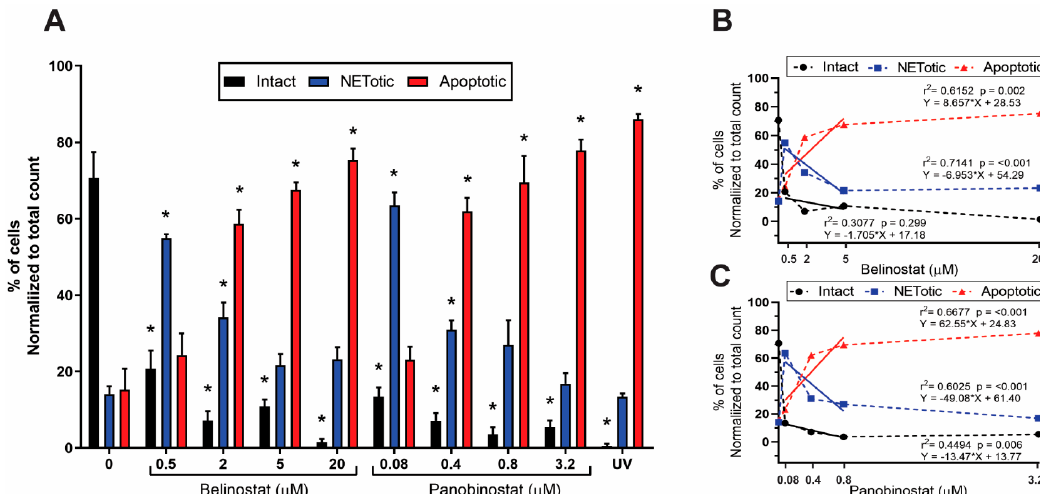
Figure 5. Quantified immunofluorescence images confirm that HDACis have increased cytotoxic effects on neutrophils and is negatively correlated with NETosis. Confocal microscopy images of neutrophils treated with negative control (RPMI), positive control (UV; 0.24 J/cm 2 ) or increasing concentrations of HDACis for 120 min were quantified by counting cells stained for DNA and MPO. ( A ) 0.5 µM belinostat or 0.08 µM panobinostat show increased levels of NETosis. However, increasing concentrations of HDAC inhibitors (2, 5 and 20 µM belinostat; 0.4, 0.8 and 3.2 µM panobinostat) show a dose-dependent decrease of NETosis and intact neutrophils but a significant increase in apoptotic cells. ( B,C ) Regression analysis show that apoptosis is positively correlated with increasing concentrations of HDACis but negatively correlated with intact and NETotic cells. The equations of regression lines, r 2 values and p -values are indicated on each panel. Neutrophil counts for each condition were then normalized to the total cell counts. * p < 0.05 (Two-Way ANOVA with Dunnett post-test, n = 3).